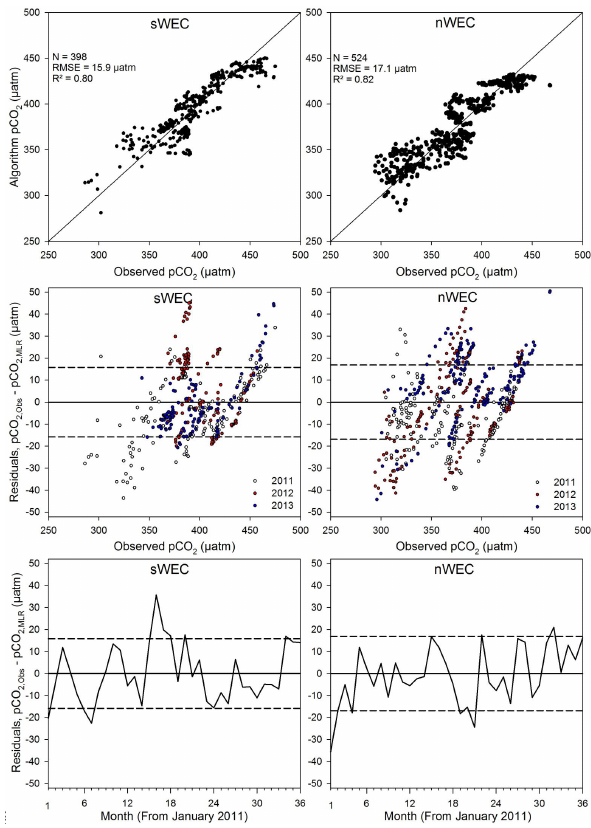
Figure 6. Observed monthly gridded p CO 2 (µatm) versus p CO 2,MLR computed from the algorithms developed in sWEC (a) and in nWEC (b) with respective number of values ( N ), R 2 and RMSE. Residuals between observed p CO 2 and predicted p CO 2 in function of observed p CO 2 values (µatm) and year of sam- pling in sWEC (c) and nWEC (d) . Mean monthly residuals (µatm) over sWEC (e) and nWEC (f) in function of the months from Jan- uary 2011. On plots C, D, E and F the dashed lines represent the RMSE of MLR developed in sWEC ( ± 15.9µatm) and nWEC ( ± 17.1µatm).